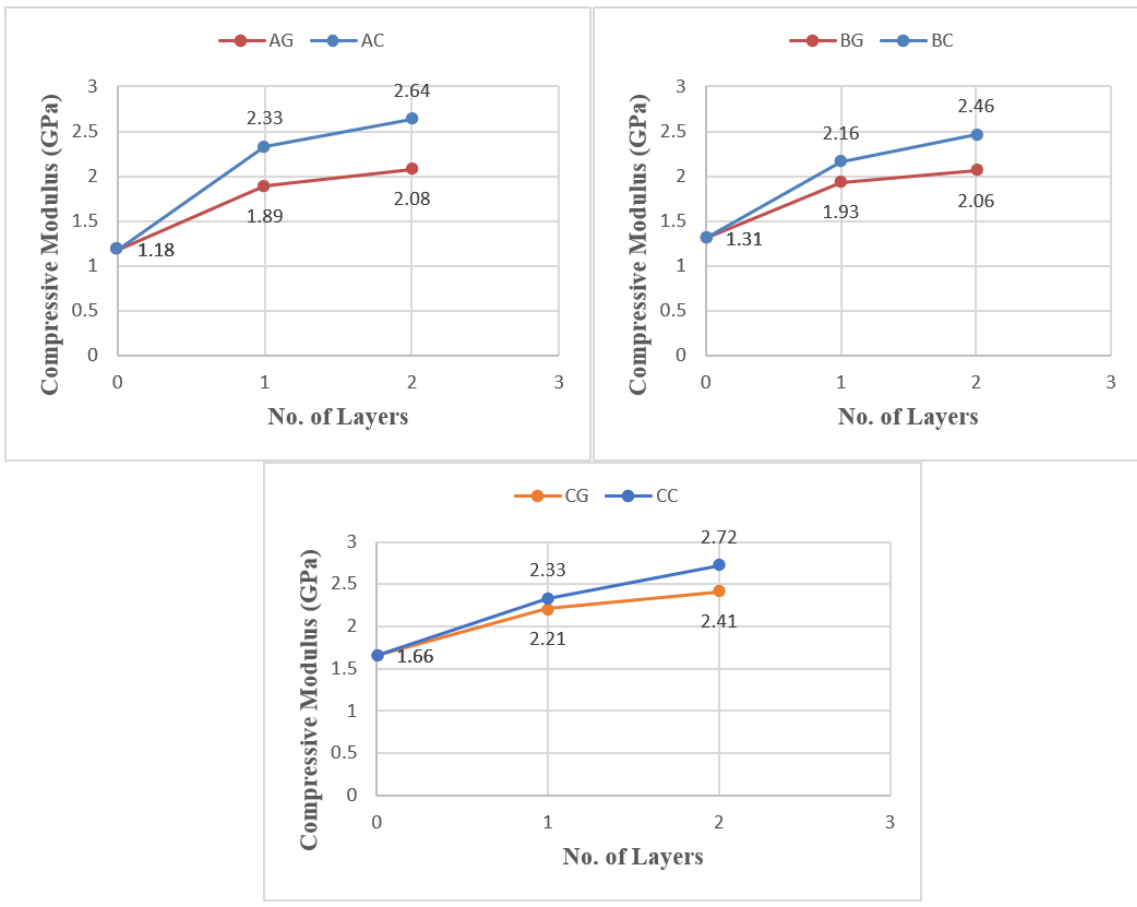
Figure 10: Graphs of compressive modulus versus no. of layers for gorups A (4+2 mm), B (3.18+1.4 mm), and C (2+1